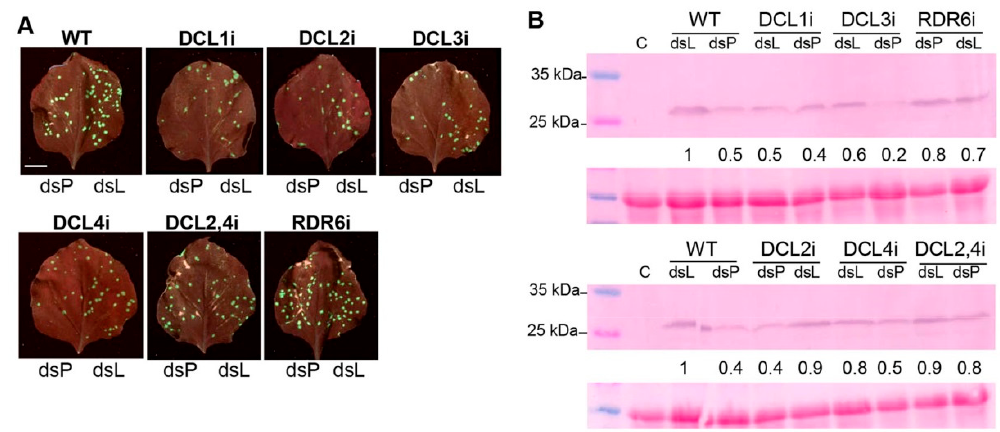
Figure 7. Side by side comparisons of RNAi mutants. ( A ) One half of the leaf from Wt and DCL1i, DCL2i, DCL3i, DCL4i, DCL2/4i and RDR6i mutant lines was inoculated with PVX-GFP plus naked dsPVX (dsP) while the opposite half was inoculated with the virus and naked dsL. Representative inoculated leaves were examined under UV light at 4 days post-inoculation. Scale bar denotes 1 cm. ( B ) Western blot analysis of plant extracts derived from inoculated leaves at 4 dpi, using antibodies against PVX CP. Lane C corresponds to extract from non-infected plant. The lower panel shows the Ponceau S-stained membrane after blotting, as a control of loading. The intensity of each PVX CP band was quantified by densitometry analyses and normalized to the Ponceau S-stained band. Protein levels in Wt leaves treated with dsL are given the value of 1 and other data were calculated relative to this value. Note that dsL and dsP treatments were inadvertently loaded in the reverse orientation in DCL2 and RDR6 mutants.